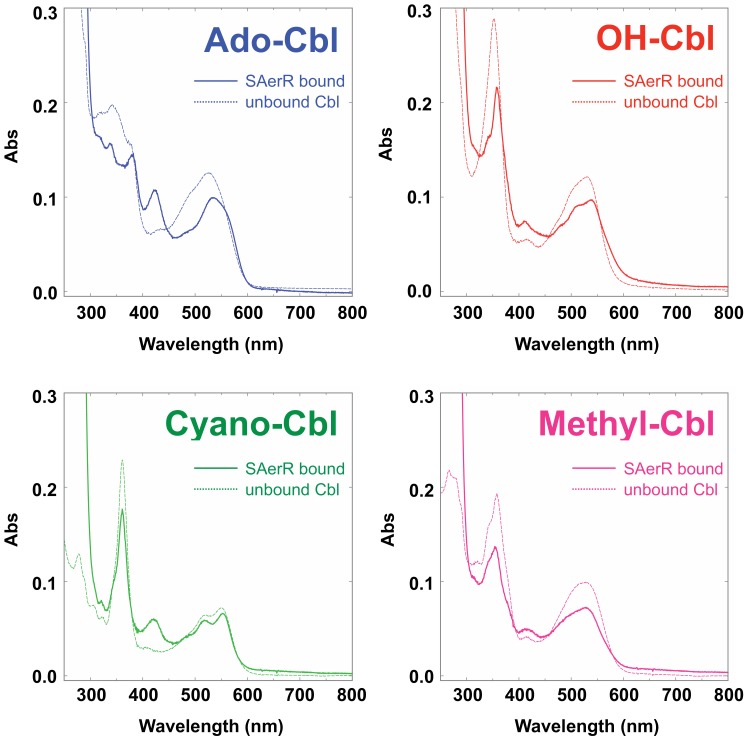
SAerR binds several kinds of cobalamin.Spectral scan of SAerR incubated with Ado-Cbl (blue), OH-Cbl (red), Cyano-Cbl (green), or Methyl-Cbl (pink) followed by removal of unbound cobalamins. Solid lines are SAerR bound form and dotted lines are protein free of unbound cobalamins.